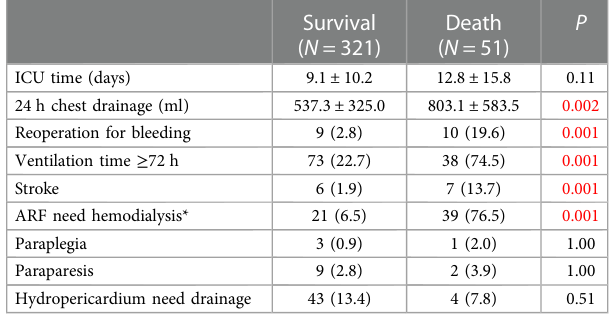
TABLE 3 Postoperative